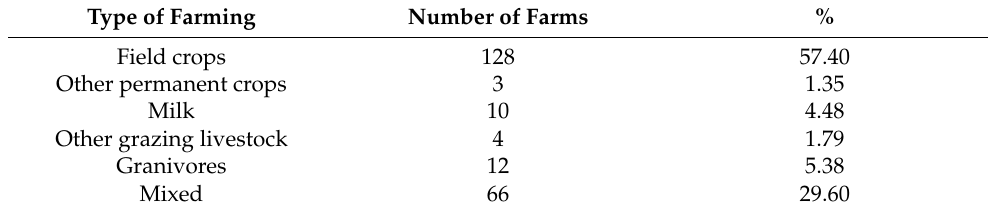
Table 2. Structure of farms by type of farming.